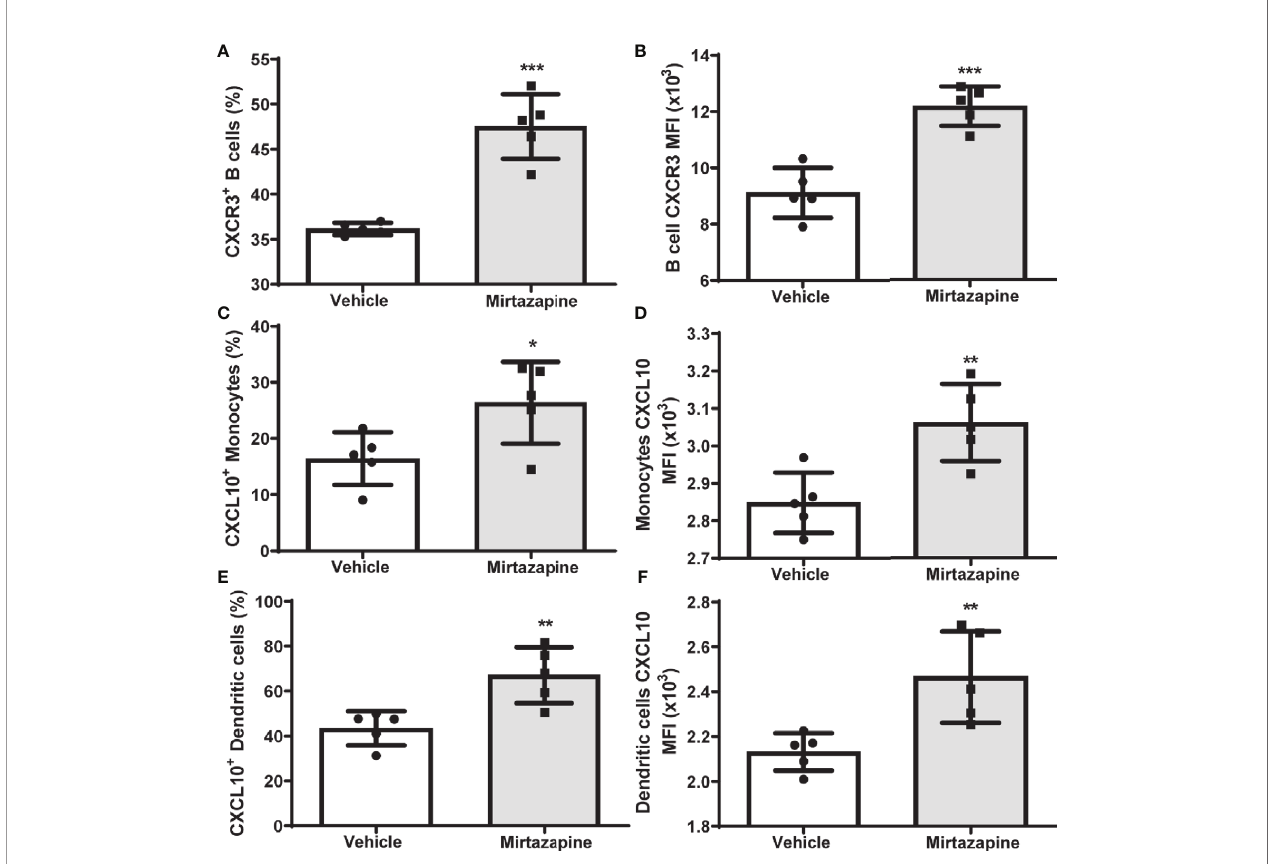
FIGURE 3 | Upregulation of hepatic CXCL10 levels and increased proportions of CXCR3-expressing hepatic B cells after mirtazapine treatment. (A) Mirtazapine treatment signi fi cantly enriches hepatic CXCR3 expressing B cells 5hrs post- treatment, compared to vehicle-treated controls (***p ≤ 0.0001; n = 5 mice/group). (B) Hepatic B cells in mirtazapine-treated mice demonstrate a higher mean fl uorescence intensity (MFI) for CXCR3 expression than B cells from vehicle-treated mice (***p ≤ 0.0003; n = 5 mice/group). Mirtazapine treatment increases production (MFI) and frequency (%) of CXCL10 + hepatic monocytes (C, D) and dendritic cells (E, F) *p ≤ 0.034 for (C) , (*p ≤ 0.0064 for (D) , **p ≤ 0.007 for (E) ; and **p ≤ 0.0099 for (F) ; n = 5